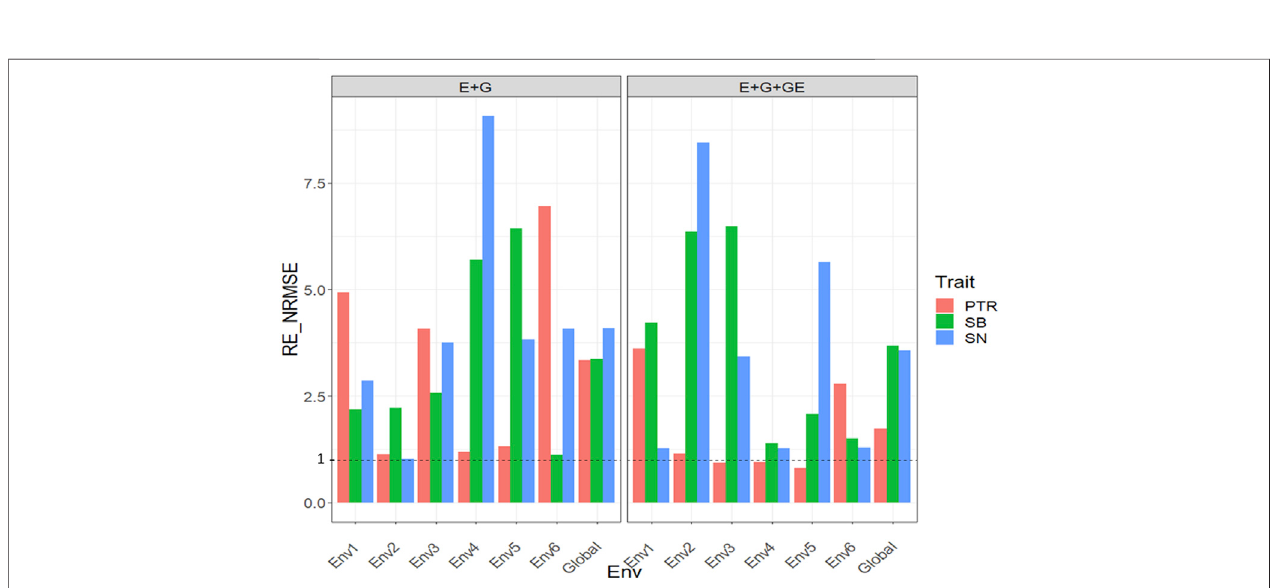
FIGURE 6 | Relative ef fi ciency in terms of normalized root mean square error (RE_NRMSE) computed by dividing the NRMSE under the best linear unbiased predictor model (GBLUP) between the NRMSE of the partial least squares regression method. Prediction performance is reported for each environment and across environments(Global)indataset6(Disease),alsowithtwopredictors(E+GandE+G+GE).WhentheRE_NRMSE > 1thePLSoutperformstheGBLUPmethodinterms of prediction performance (lower NRMSE).